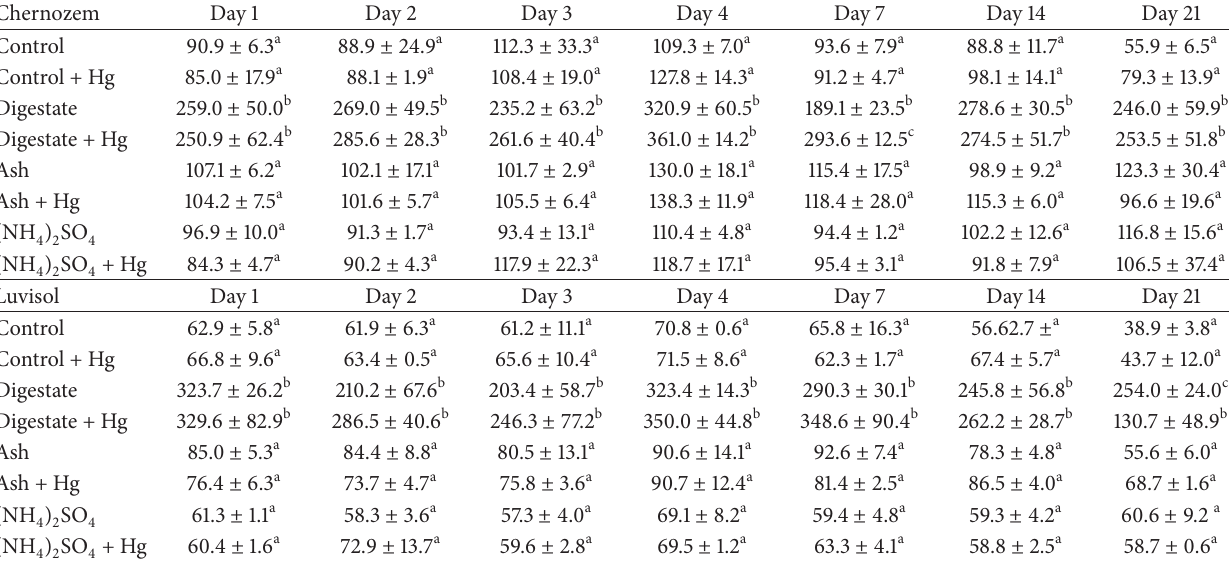
Table 9: The concentrations of P extractable with 0.11molL − 1 acetic acid within the incubation experiment (mg ⋅ kg − 1 ); the averages marked by the same letter did not significantly differ at 𝑃 < 0.05 within individual columns; data are presented as mean ± standard deviation ( 𝑛 = 3 ).